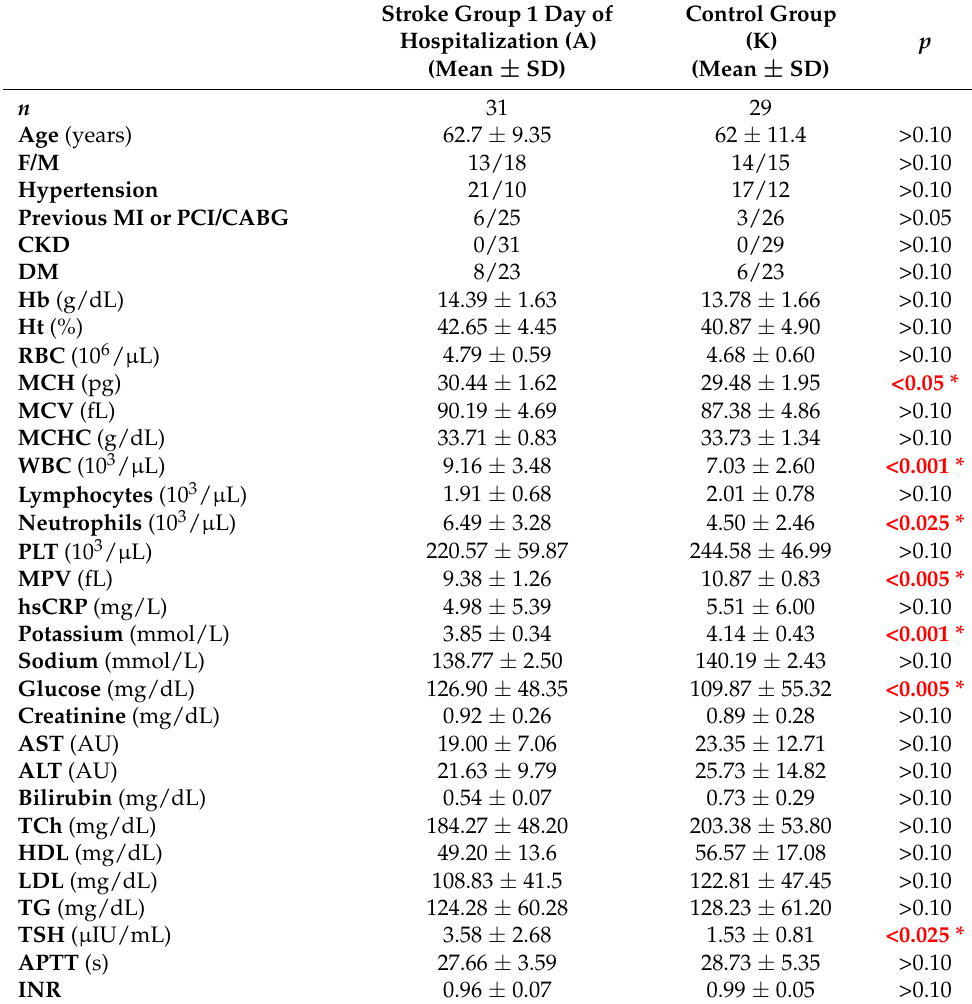
Table 1. Demographic, biochemical, and clinical characteristics of the stroke and control